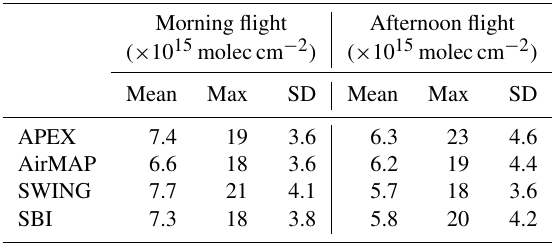
Table 6. NO 2 VCD map product statistics for the morning and af- ternoon